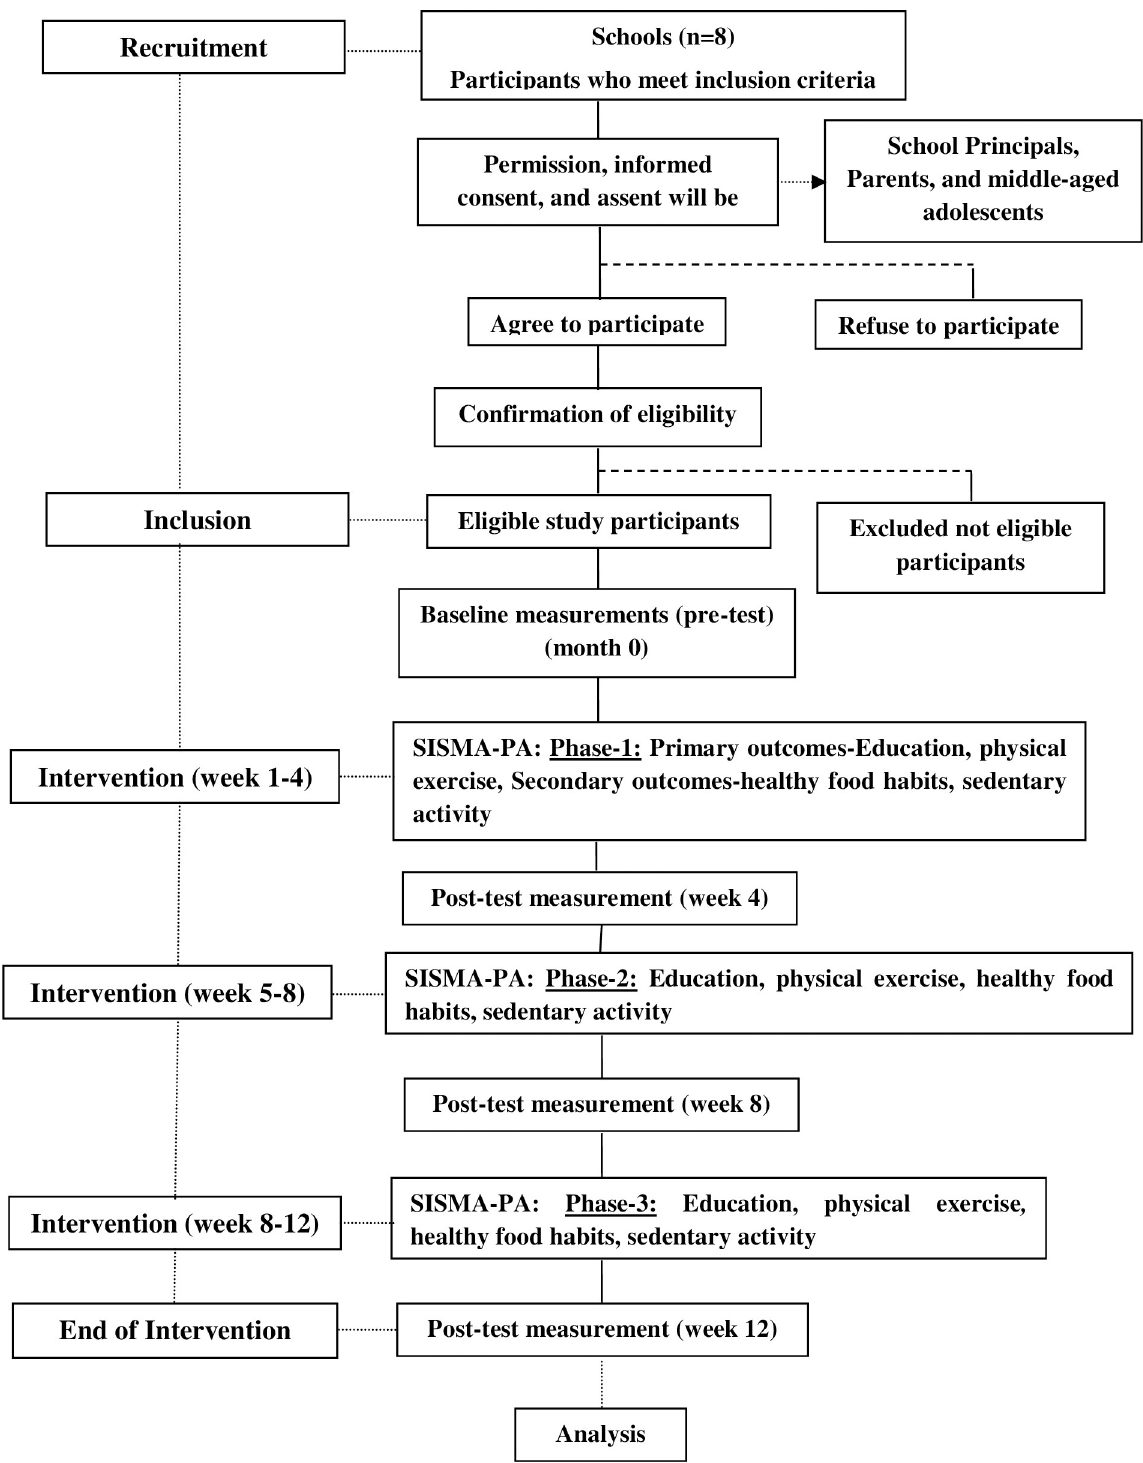
Fig 2. SISMA-PA planned pre-post time-series study design. SISMA-PA = Structured Interventional Strategy for Middle-aged Adolescence for Preventing Atherosclerotic risks.